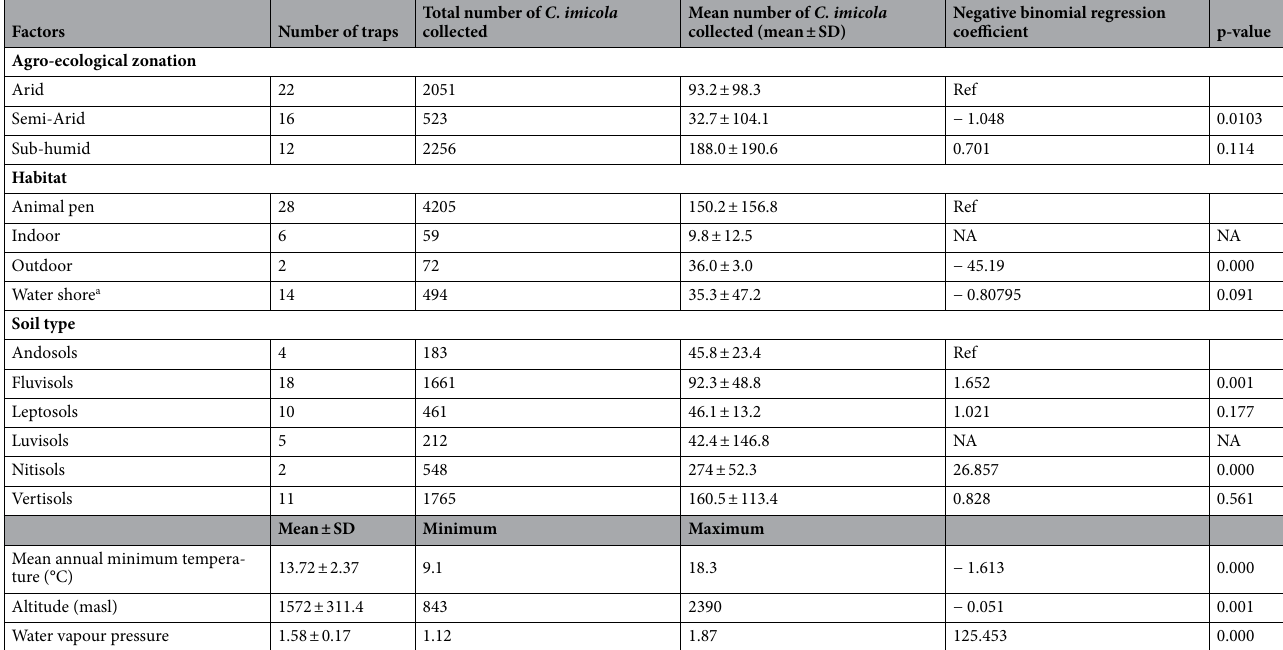
Table 4. Factors associated with C. imicola occurrence using multivariate negative binomial regression analysis. a Water shore includes river side, near pond, and lake shore.